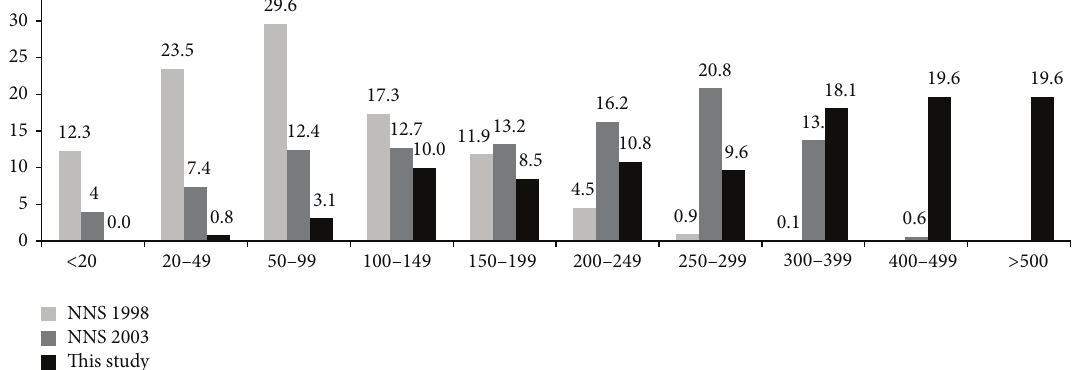
Figure 1: Distribution of urinary iodine concentrations ( 𝜇 g/L) in schoolchildren in the Philippines in 1998, 2003, and 2013. Table 1: Urinary iodine concentration from a total of 260 high school students in Tuguegarao. Median